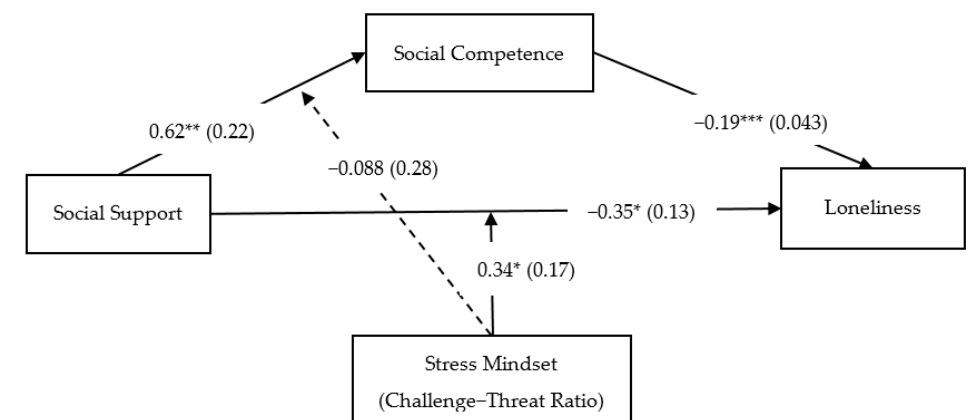
Figure 2. The final model: The association between social support and loneliness was mediated by migrant children’s social competence and moderated by their stress mindset (indicated by the challenge–threat ratio). Note. The challenge–threat ratio was calculated by dividing the stress-is-a-challenge mindset by the stress-is-a-threat mindset. *** p < 0.001. ** p < 0.01. * p < 0.05.